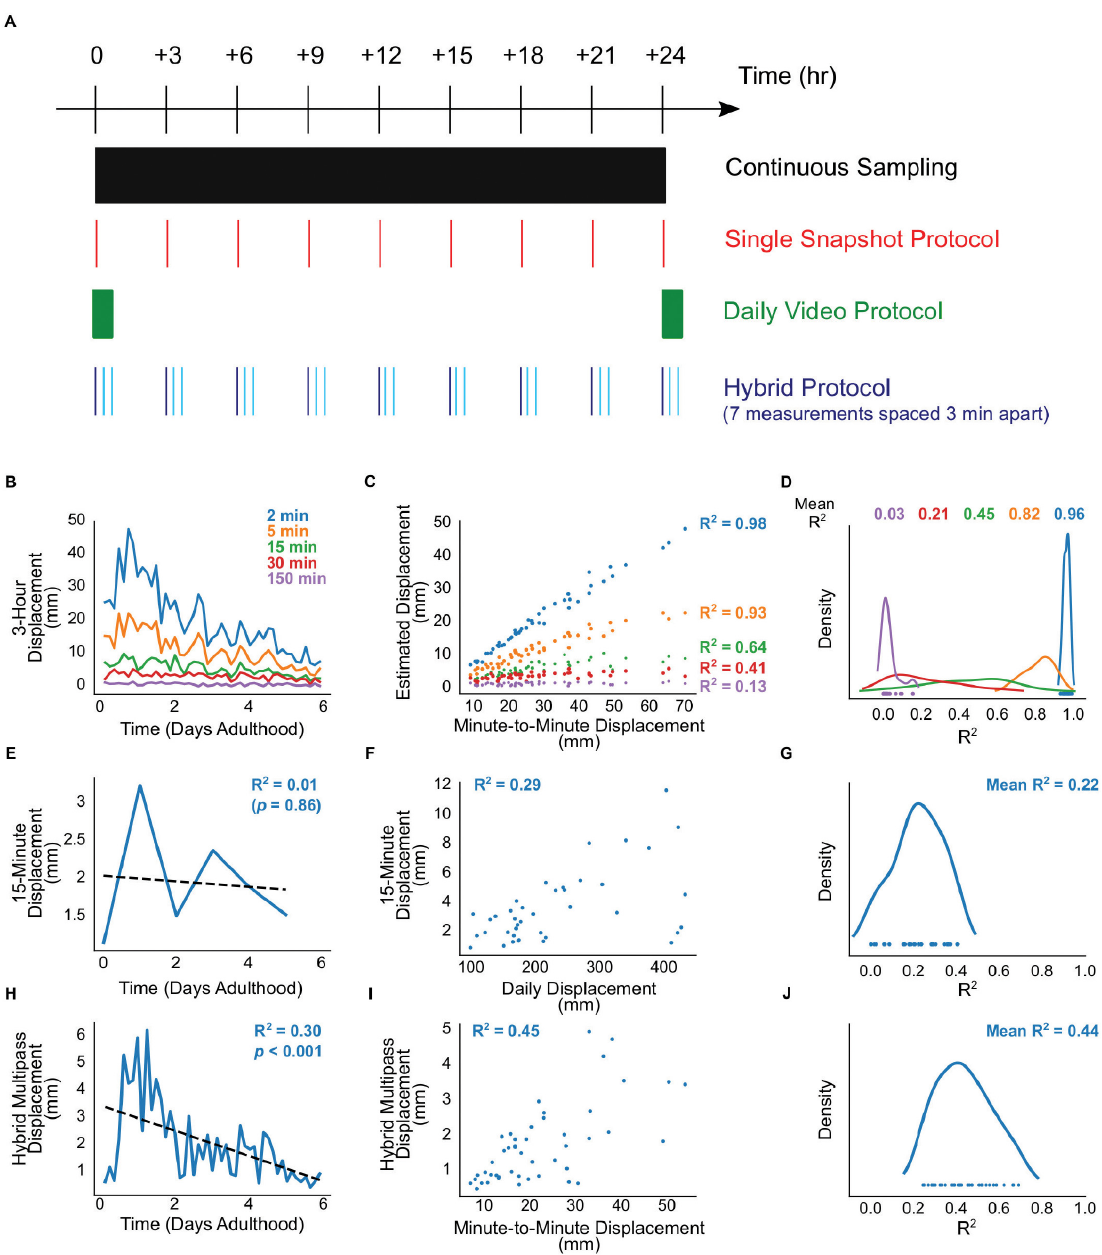
Fig 5. Comparison of validity of three movement protocol schemes. (A) Graphical cartoon of the various protocols of interest. The “Continuous Sampling” condition is the baseline-quality data collected in this study. In the "Single Snapshot" protocol, one image per timepoint is taken, and the movement score for that timepoint is the displacement of the individual’s centroid from the previous timepoint. The "Daily Video" protocol consists of 15 images obtained per timepoint at 1 fpm; the movement score for that timepoint is the summed total displacement across all 15 images acquired in that day’s timepoint. Finally, in the "Hybrid Multipass" protocol, several images per timepoint are taken with a wider temporal spacing (allowing image acquisition for several individuals to be interleaved) and the total displacement across those images is used as the movement score for that timepoint. Here, we acquire 7 images each spaced 3 minutes apart (for a total interval of 18 minutes). (B-D) Illustration of data generated by the Single Snapshot protocol at various inter-timepoint intervals. (B) One individual’s activity across the first 6 days of adulthood. (C) For that individual, the correlation between the total displacement during those intervals (measured from gold-standard 1 fpm data) and net displacement using the specified inter-timepoint interval. (D) Kernel density plot showing the distribution of correlations between 1 fps and Single Snapshot obtained for all individuals at the various inter-timepoint intervals. (E-G) Illustration of the data generated by the Daily Video protocol at various inter-timepoint intervals. (E) Activity from the same individual in panel B, across the first 6 days of adulthood. (F) The correlation between the total displacement during